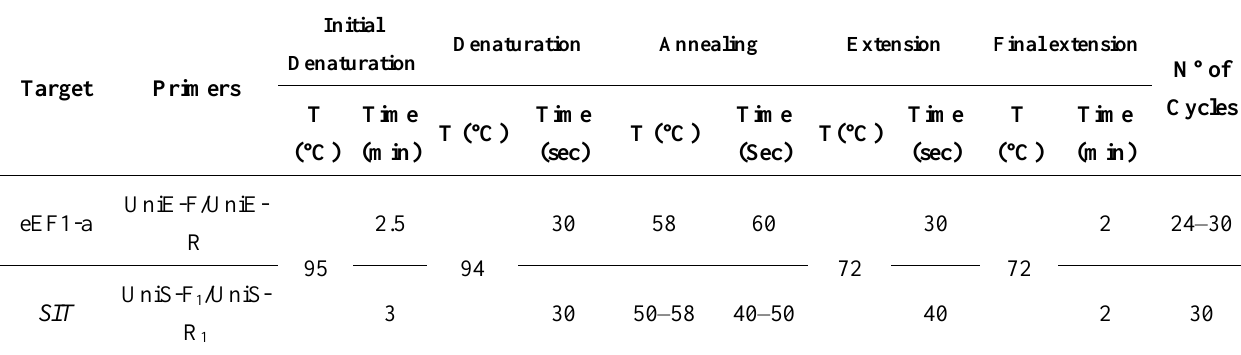
Table 2. Polymerase Chain Reaction conditions used to amplify selected fragments